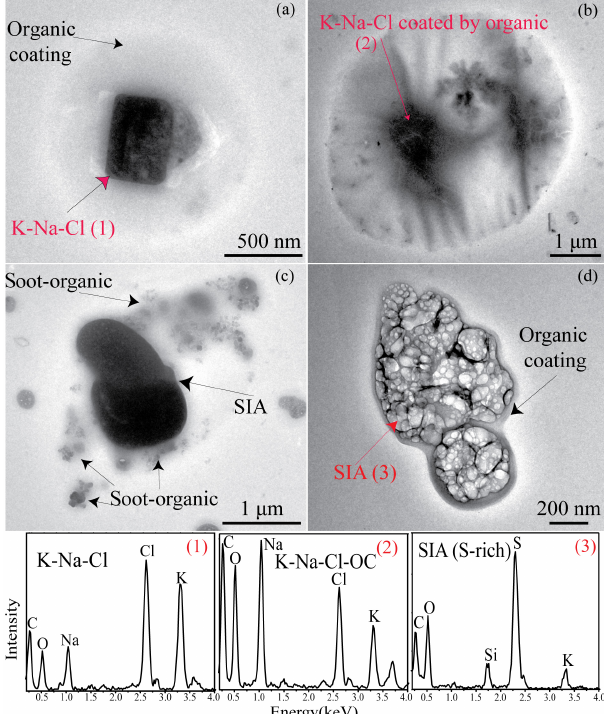
Figure 4. TEM images of a (a–b) K–Na–Cl particle with organic coating on 22 September and 13 October. (c) SIA–soot with organic coating on 22 September. (d) SIA with organic coating on 11 Octo- ber. EDS spectra show elemental compositions of each particle type in each TEM